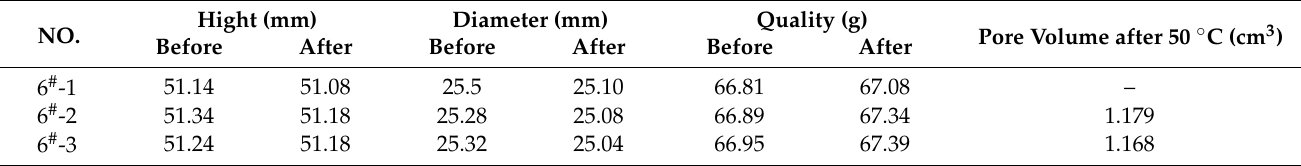
Table 1. The basic physical parameters of shale samples under 50 °C temperature treatment.